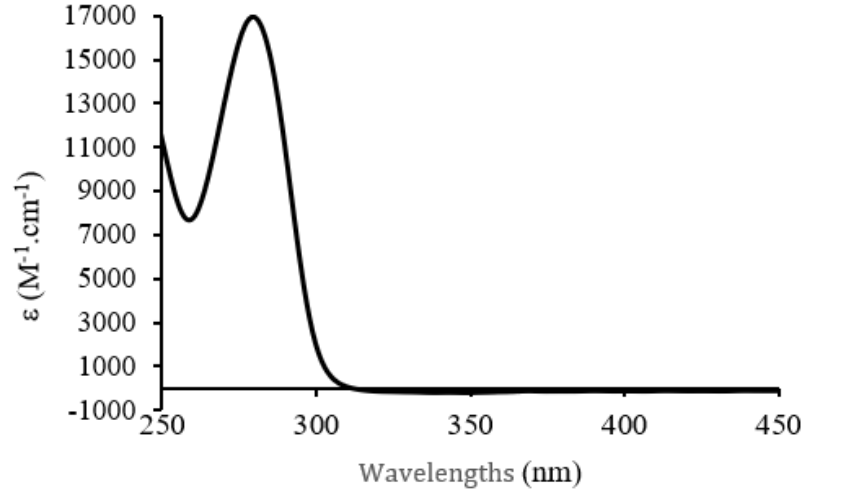
Figure 13. UV-visible absorption spectrum of C7 in D 2 O C = 1 × 10 -3 mol·L − 1 . Concerning the luminescence spectra of C7 in D 2 O excitation at 290 nm causes lumi- nescence emission of the molecule at 314 nm (Figure 14).